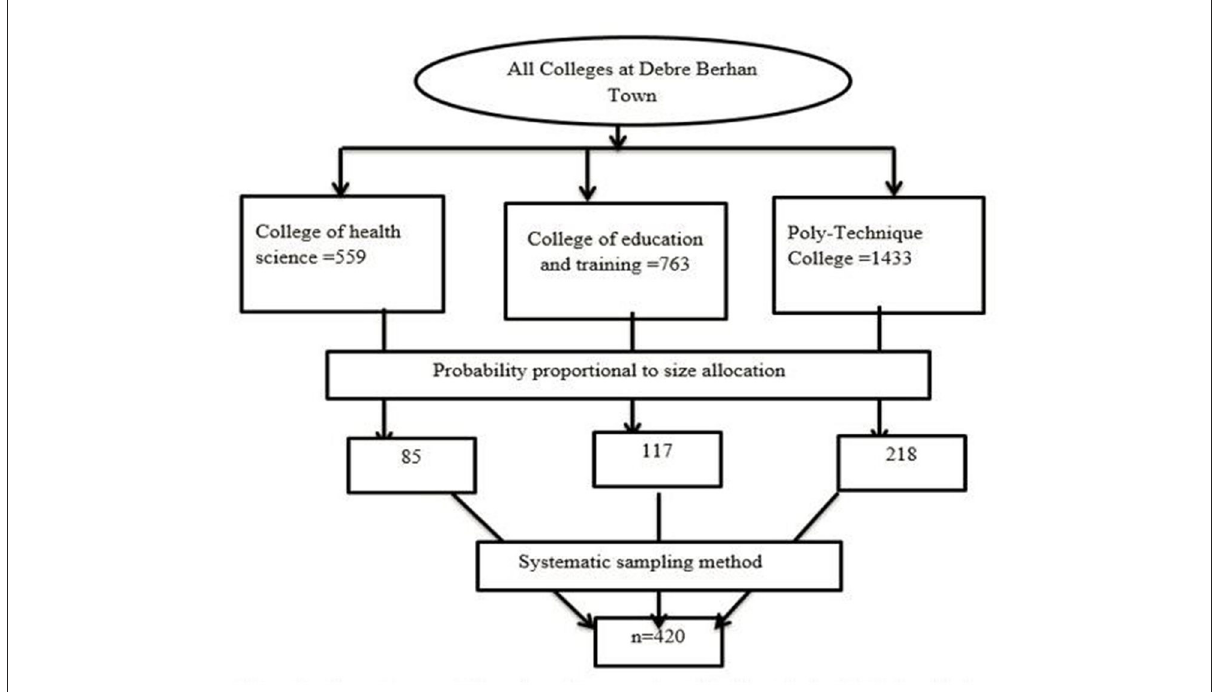
FIGURE1 Schematic presentation of sampling procedure of college students in Debre Berhan town,